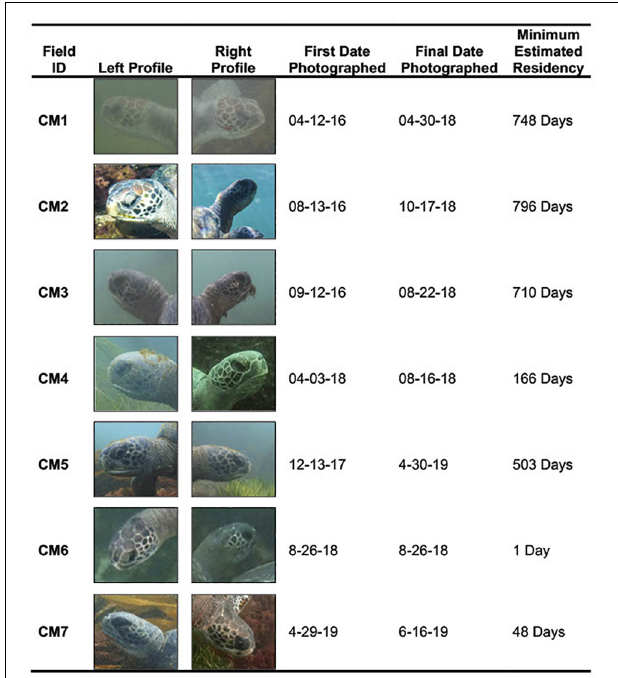
FIGURE 7 | Shows all seven individuals that were digitally tagged in the study site with their corresponding field ID, left and right profiles for each individual, first date photographed in database, most recent date photographed in database, and minimum estimated residency (MRD) in study site. Photographs taken by Jamie Leslie Feldman, Erin M. Chandler, and Trystan